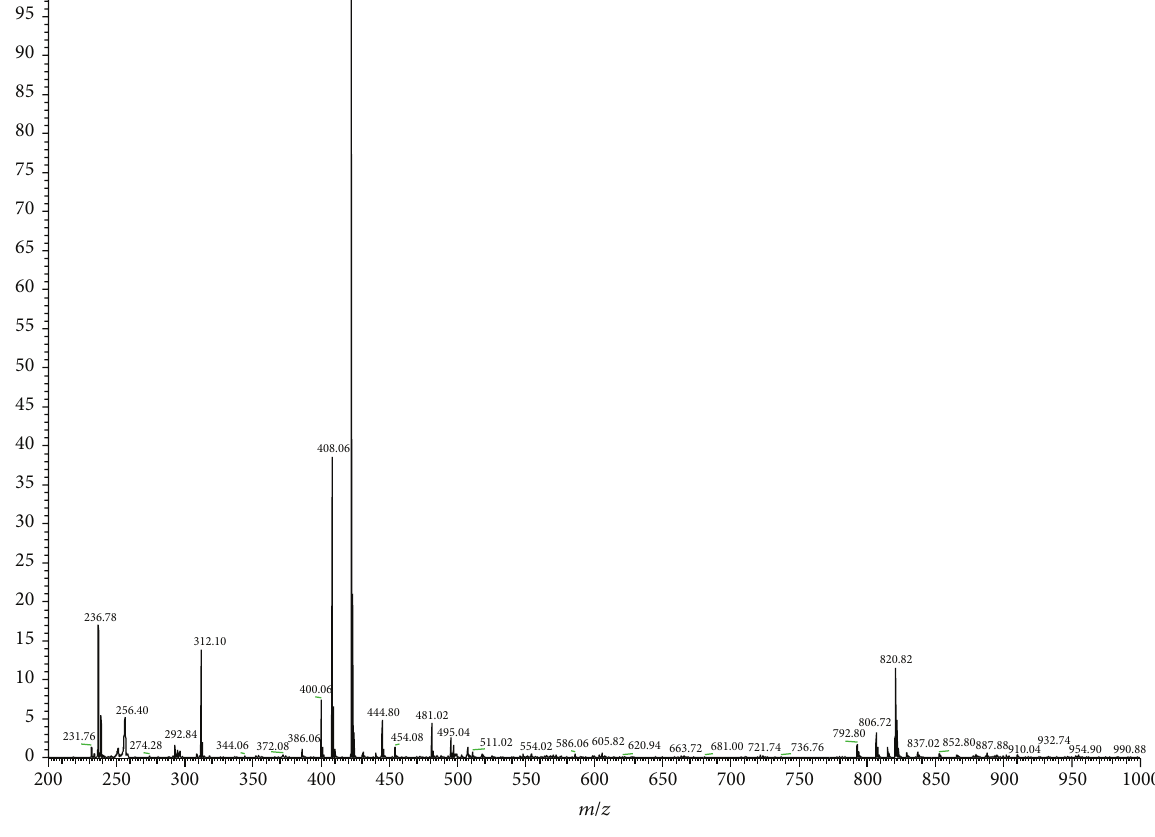
Figure 2: Electrospray mass spectrometry of